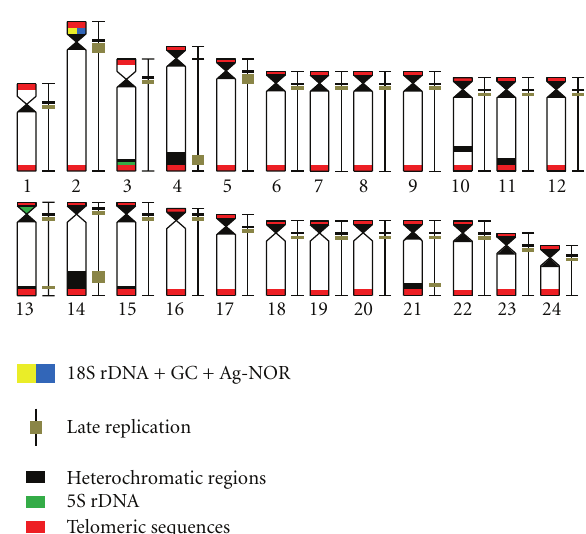
Figure 2: Idiogram of the chromosome complement of Rachy- centron canadum , exhibiting cytogenetic mapping of ribosomal sequences, Ag-NORs, heterochromatic regions, and chromosome replication bands. Bar = 5 μ